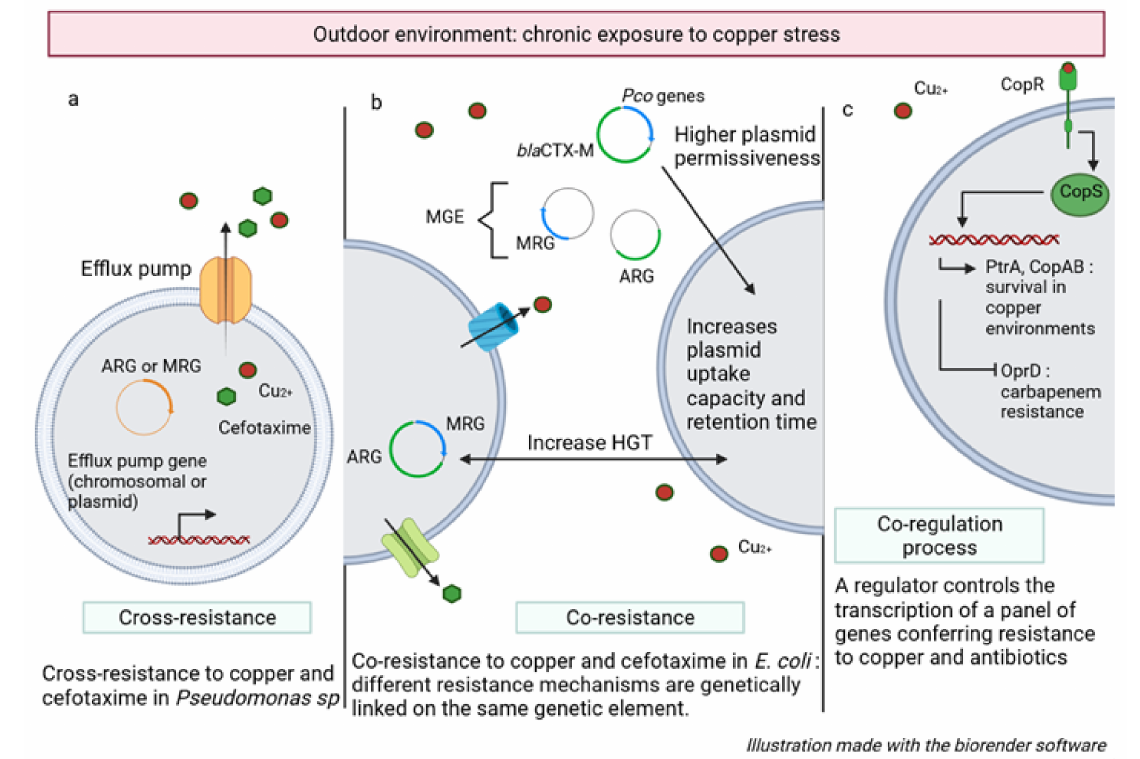
Figure 2. The co-selection of antibiotic and metal resistant bacteria. ( a ) cross-resistance; ( b ) co-resistance; ( c ) co-regulation